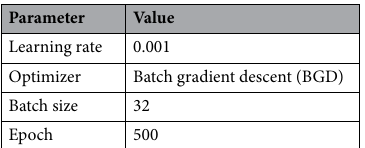
Table 5. Parameters setting of the developed deep